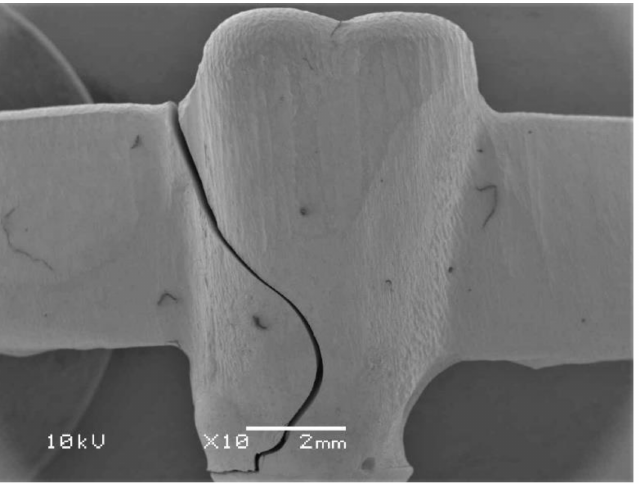
Figure 4. Representative scanning electron microscopic image showing the fractured